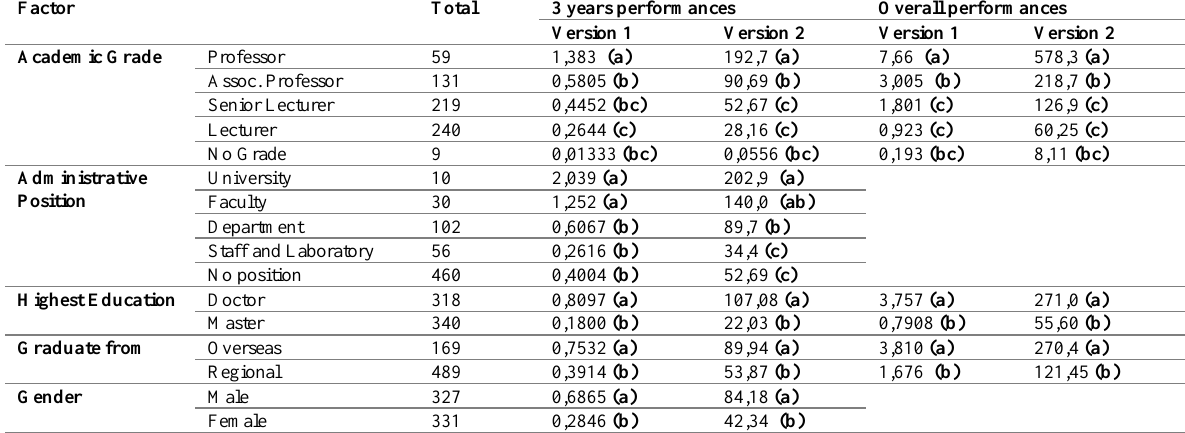
Table 5 : Average and Tukey Test